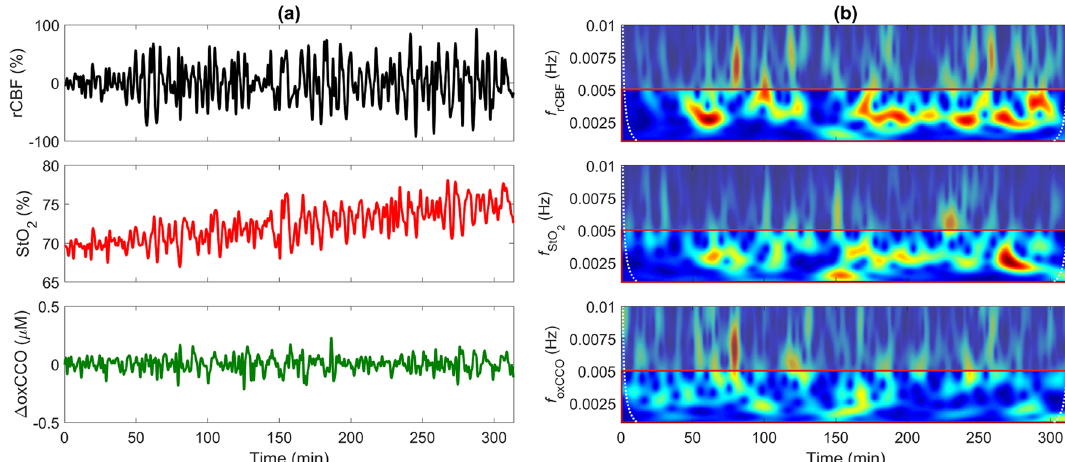
Figure 1. ( a ) Time courses of relative cerebral blood flow (rCBF), tissue saturation (StO 2 ), and change in the oxidation state of cytochrome c oxidase (ΔoxCCO) for one patient on the first day of life. ( b ) Corresponding frequency-time plots generated by wavelet transform of rCBF, StO 2 , and ΔoxCCO. The red box highlights the frequency band of notable CBF oscillation (0.001 to 0.005 Hz). The dotted white lines indicate the cone of influence. Wavelet values outside this region were considered distorted due to edge artefacts 56 .